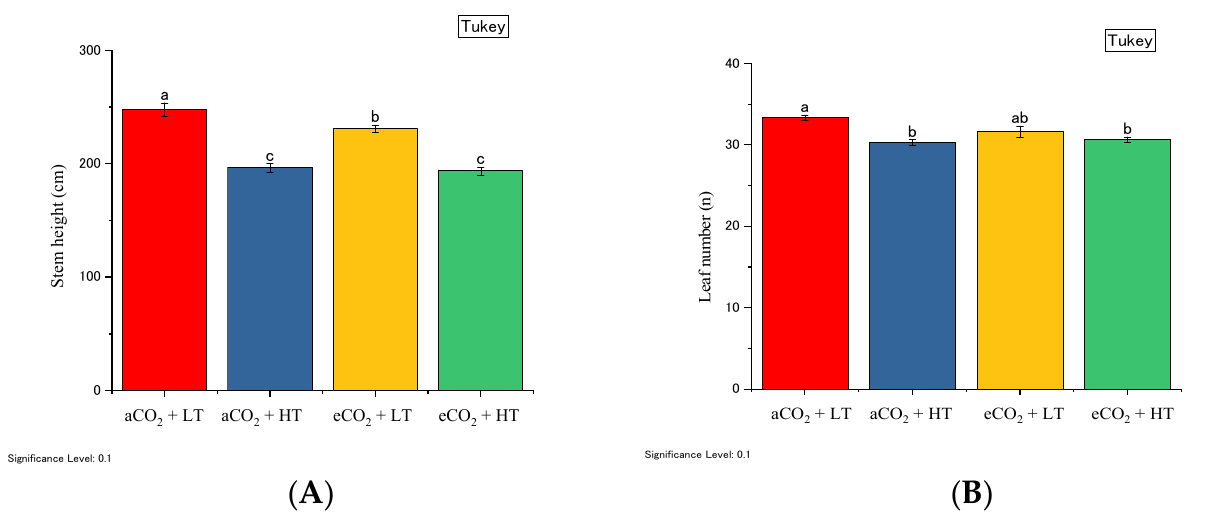
Figure 3. ( A ) Stem height and ( B ) leaf number at 14, 21, 28, 35, and 43 d after transplantation under aCO 2 + LT, aCO 2 + HT, eCO 2 + LT, and eCO 2 + HT treatments. Vertical bars represent standard error (SE) of mean ( n = 10). For all variables with the same letter, the difference between the means is not statistically significant. If two variables have different letters, they are significantly different. Owing to eCO 2 levels throughout the growth period, notable differences in dry matter accumulation were observed in plants exposed to different DNF treatments (Figure 4). In the LT treatment, although eCO 2 did not affect leaf dry weight, it increased the total dry weight by 30% (Figure 4). In contrast, eCO 2 increased leaf dry weight by 28% without altering the total dry weight of the plants exposed to HT (Figure 4). Moreover, the eCO 2 and DNF treatments exhibited long-term effects on dry matter accumulation compared with morphological characteristics (Figures 3 and 4). However, variations in dry matter accumulation were not recorded until 20 d after transplantation (Figure 4).